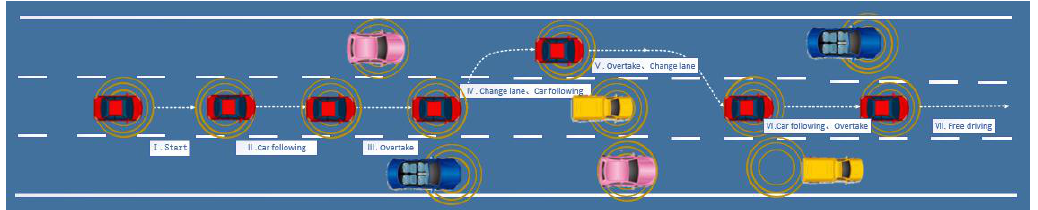
Figure 13. The test process.